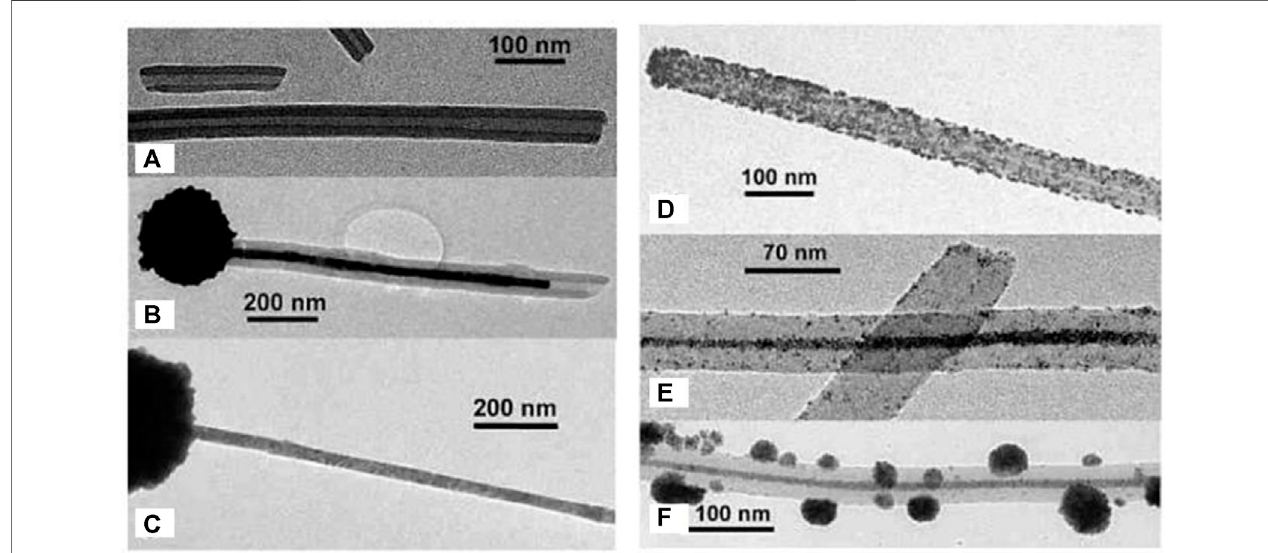
FIGURE 16 | TEM of two-porphyrin nanotubes used as templates for noble metals: (A) porphyrin nanotubes; (B) porphyrin nanotube with gold nanostructure obtained by photoreduction; (C) free-standing gold wire obtained after the porphyrin tube has been dissolved away; (D) porphyrin nanotube with Pt nanoparticles distributed mainly on the outside surface; (E) a long Pt dendrite in the core of the tube obtained at higher Pt-concentration; (F) later stage in the development with a Pt dendrite in the core and globular Pt dendrites on the outer surface of the nanotube (Wang et al., 2004a). Reprinted with permission. Copyright © 2004 American Chemical